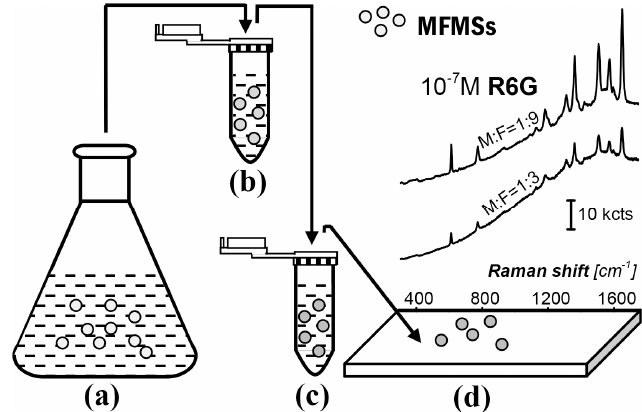
Figure 1. A route for the fabrication and use of SERS substrate AgNP/MFMSs. ( a ) Synthesis reaction with melamine and formaldehyde for MFMSs; ( b ) adsorption of AgNPs on the MFMSs in silver colloidal solution; ( c ) incubation of the AgNP/MFMSs sample in the R6G solution; and ( d ) interrogation of the SERS substrate sample with Raman spectroscopy.